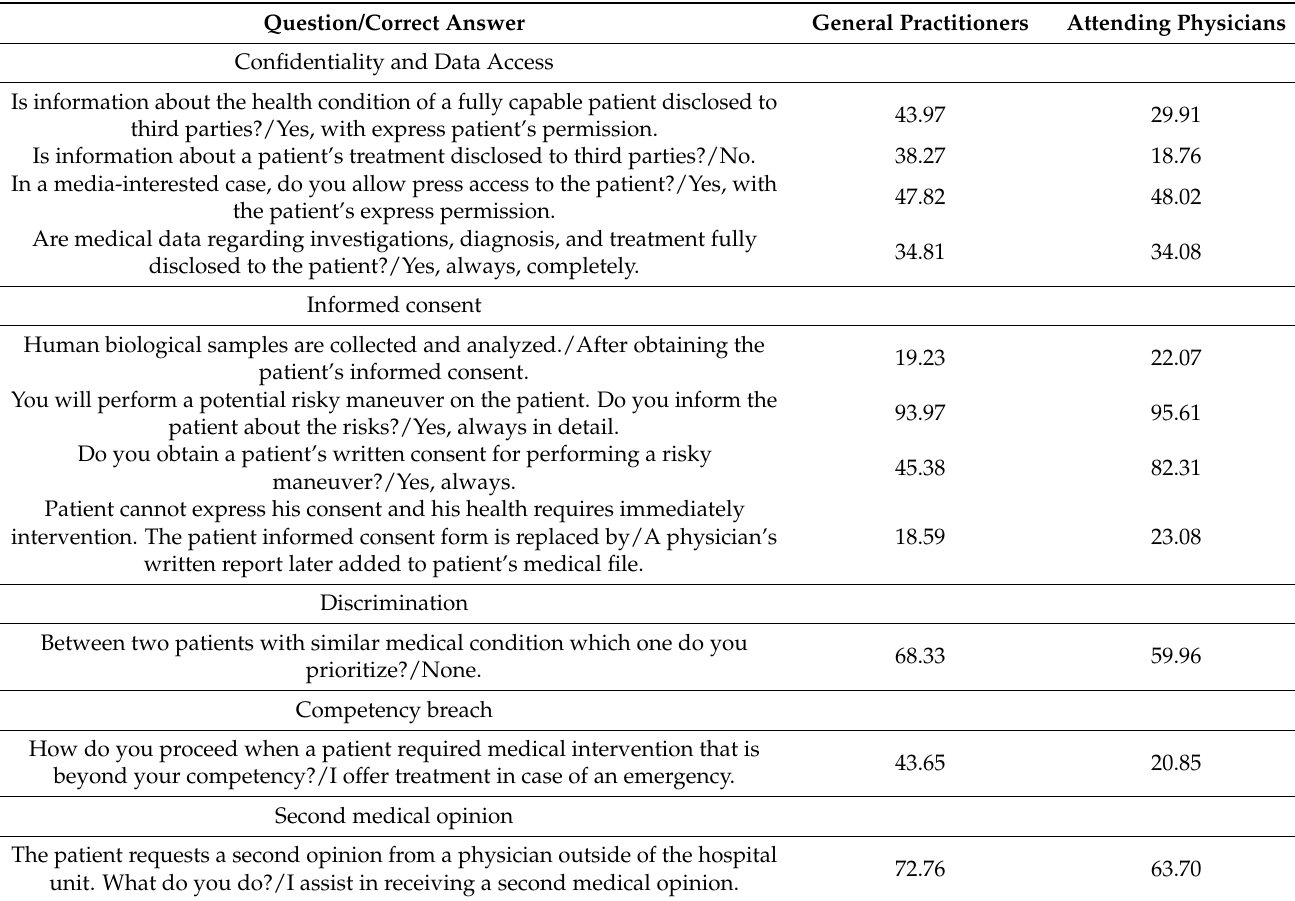
Table 2. Physicians’ legal compliance at a national level (%).